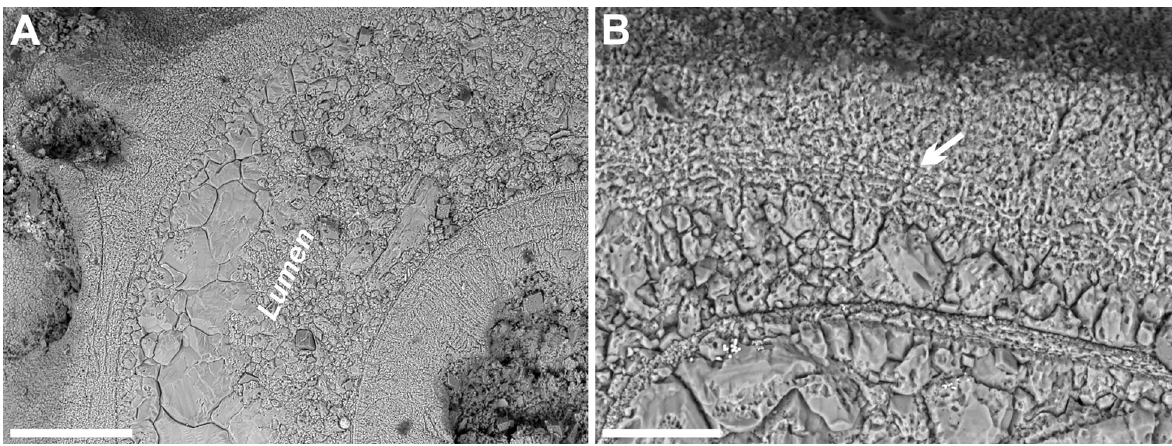
Fig. 4. Sectioned and polished tube of Palaeoconchus wilsoni sp. nov. from Kuressaare, Estonia, GIT 687-1-1. A , smooth lumen, devoid of any annulations; scale bar 200 µm. B , diagenetically altered tube, showing poorly preserved lamellar microstructure (arrowed); scale bar 50